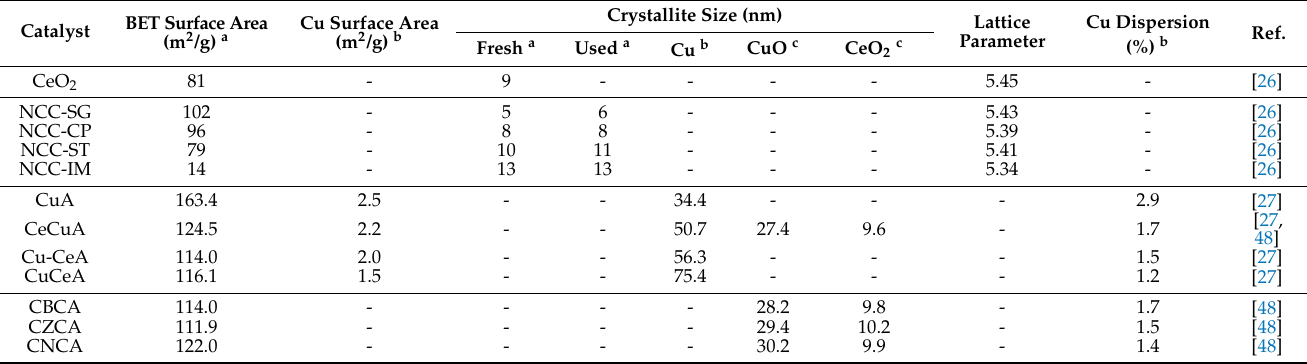
Table 5. Characteristics of Cu-based catalysts.